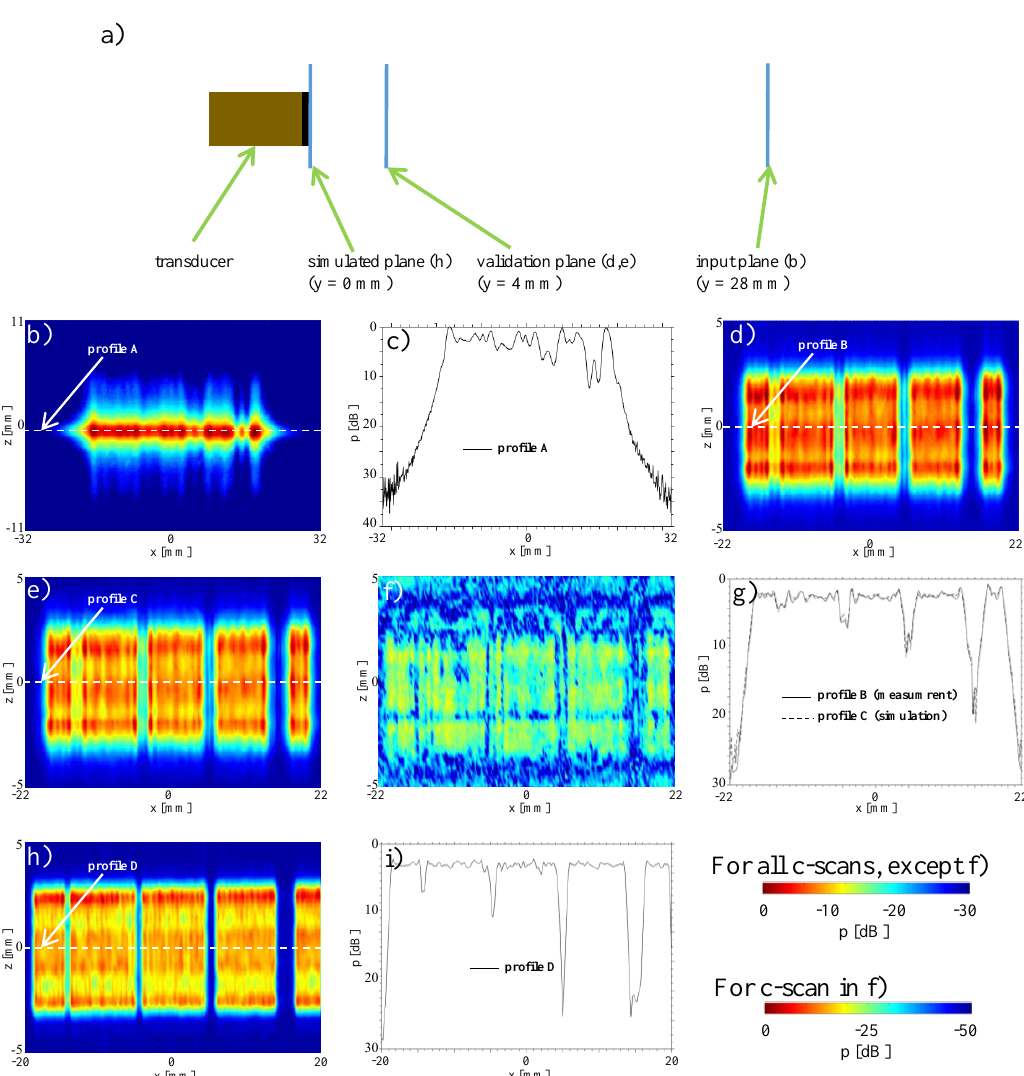
Figure 4. Identification of broken elements: ( a ) setup; ( b ) measurement of the pressure distribution in a x , z -plane 28 mm in front of the transducer; ( c ) measurement profile y = 28 mm, z = 0 mm; ( d ) measured sound field 4 mm in front of transducer ( y = 4 mm); ( e ) simulated sound field 4 mm in front of transducer ( y = 4 mm); ( f ) difference (c-scan) between measurement and simulation 4 mm in front of transducer ( y = 4 mm); ( g ) difference profile between measurement and simulation 4 mm in front of transducer ( y = 4 mm, z = 0 mm); ( h ) simulated sound field directly in front of transducer ( y = 0 mm); ( i ) amplitude profile directly in front of the transducer y =